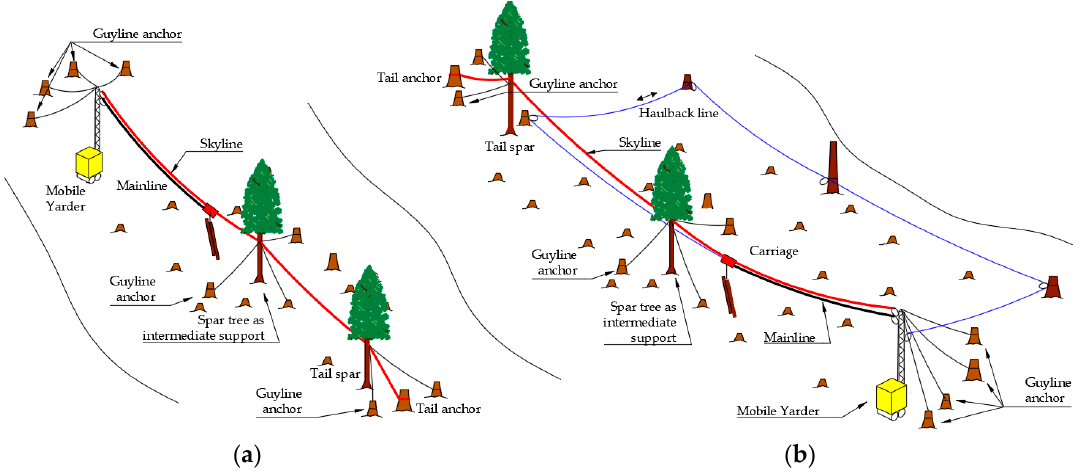
Figure 2. Example of a multi-span cable logging system for a two-drum mobile yarder ( a ) and for a three-drum mobile yarder ( b ).